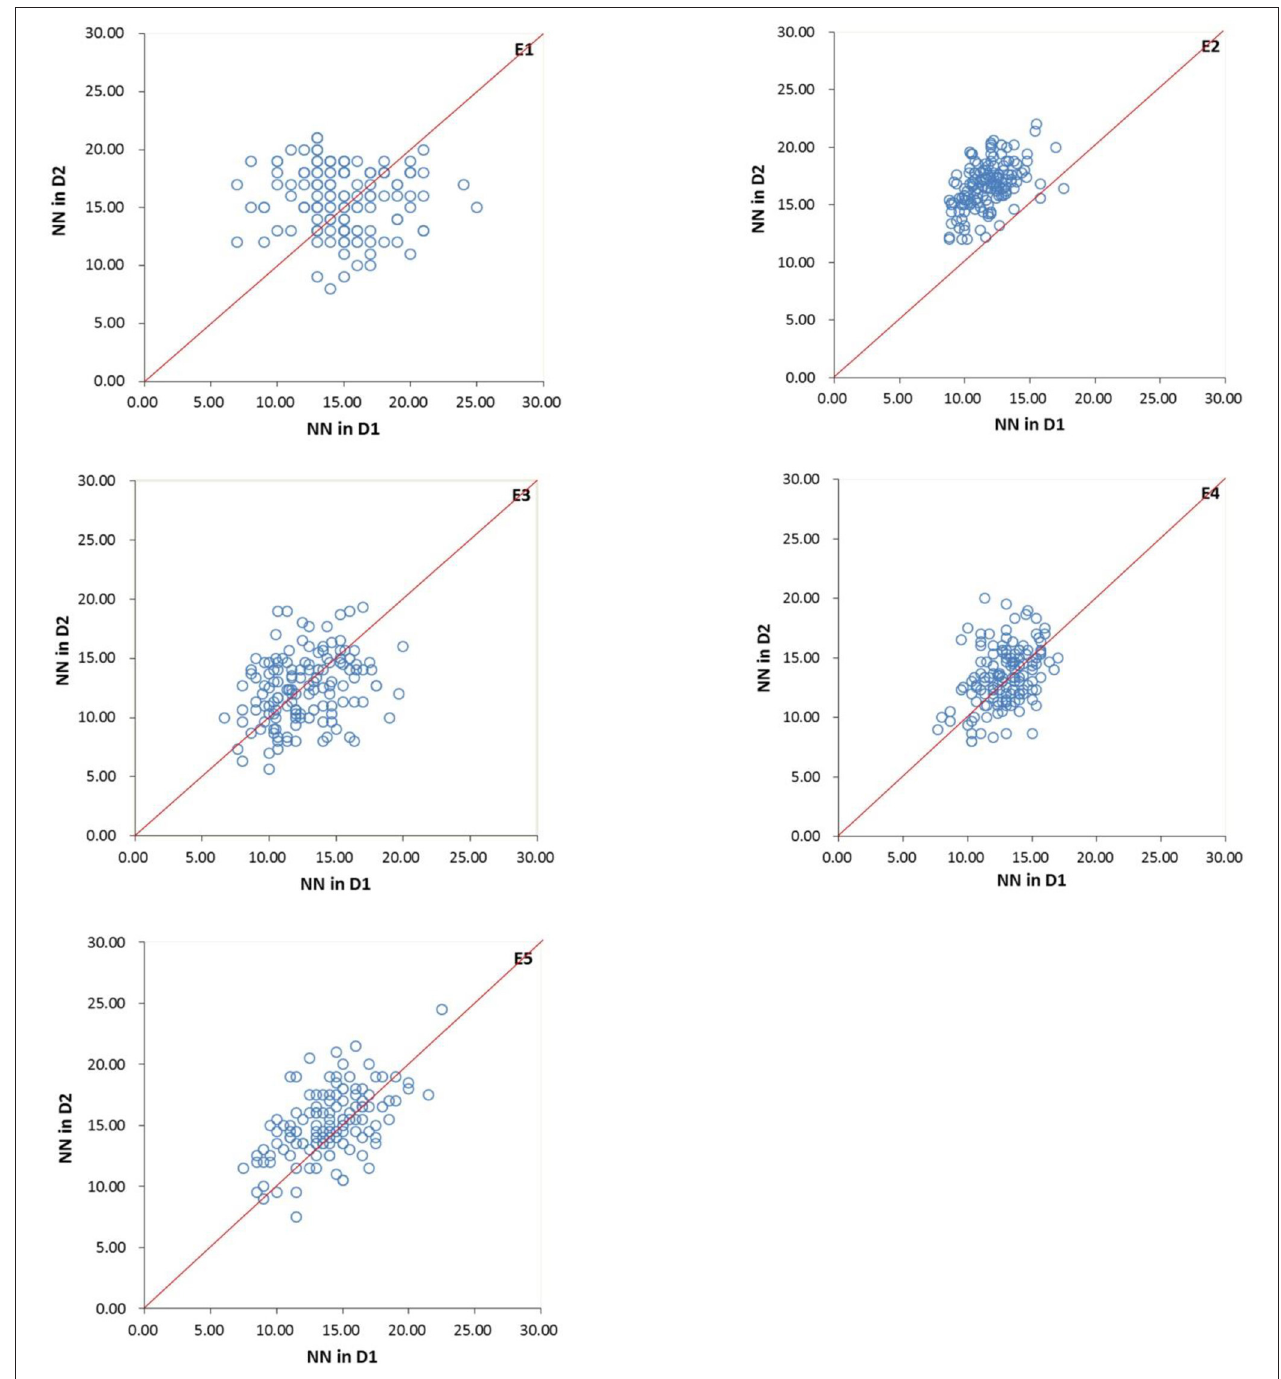
FIGURE 2 | Variation in main stem node number (MSNN) under two densities in five environments for four-way recombinant inbred line (FW-RIL). E1, Harbin in 2015; E2, Keshan in 2015; E3, Acheng in 2016; E4 Shuangcheng in 2016; E5, Harbin in 2016; D1, normal density (2.2 × 10 5 plants/ha); D2, high density (3 × 10 5 plants/ha).